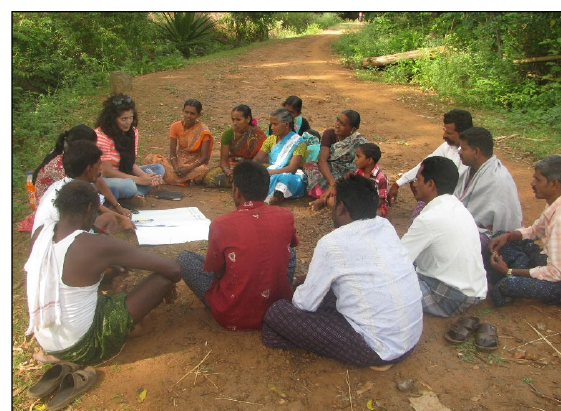
Figure 3. Participatory Rural Appraisal (PRA)